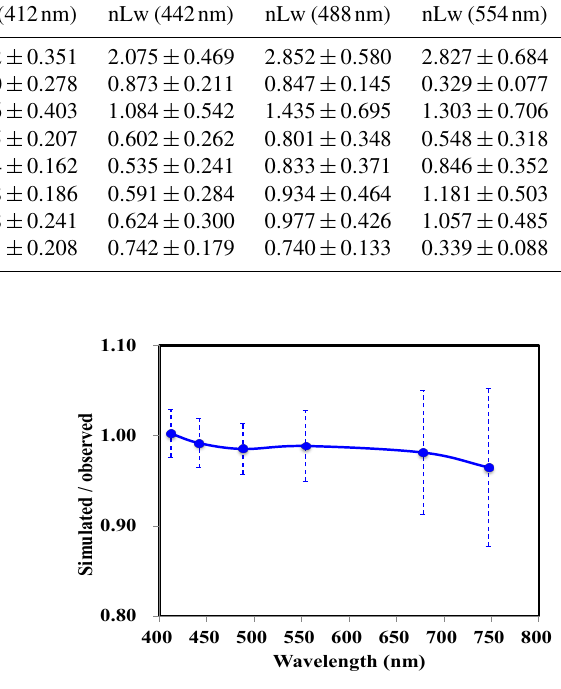
Figure 3. Spectra of AAOT nL w used for the calculation of vicar- ious calibration coefficients in this study. The gray lines represent the individual spectra; the black line shows the average spectrum; the dotted lines denote the average spectrum ± 1SD.